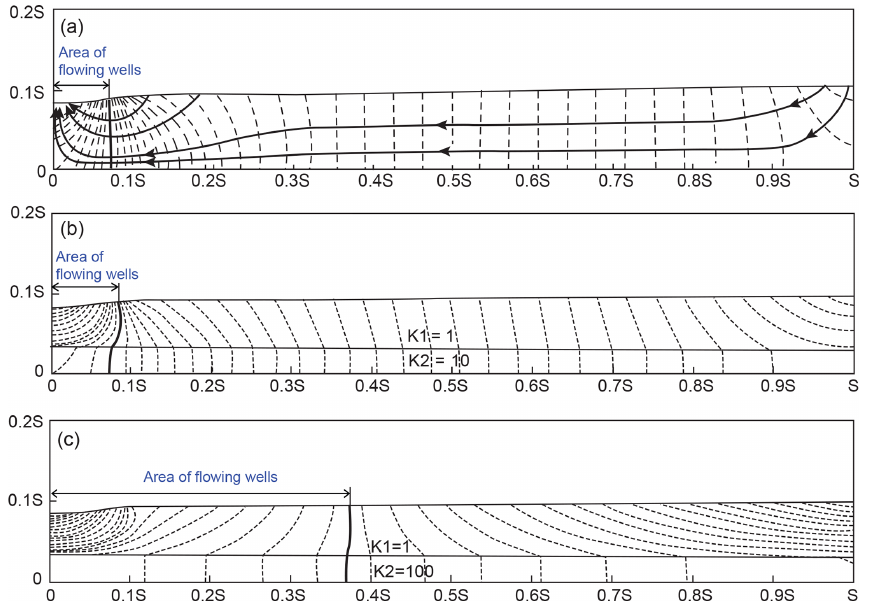
Figure 9. The distribution of equipotential lines and area of flowing wells in homogeneous (a) and heterogeneous basins (b, c) (modified from Freeze and Witherspoon, 1967). Also shown in (a) is the streamlines showing the pattern of groundwater flow from the recharge to the discharge area.